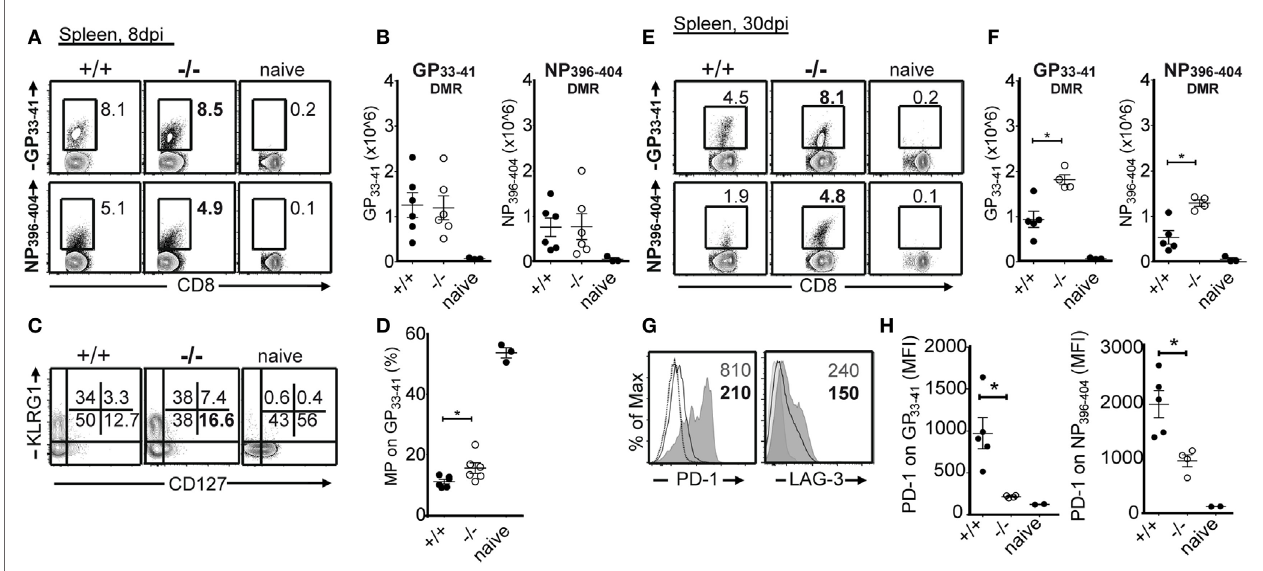
FigUre 2 | PTPN22 − / − mice exhibit enhanced virus-specific CD8 T cell numbers and reduced exhaustion phenotype. PTPN22 + / + (black circles) and PTPN22 − / − (white circles) mice were infected as described in Figure 1 . (a,B) Virus-specific splenic T cell populations were analyzed 8 dpi using GP 33–41 and NP 396–404 dextramers (DMRs) (gate: CD3 + B220 − CD8 + CD44 + ). (c,D) CD127 and KLRG1 costaining was used to distinguish terminal effector (CD127 − KLRG1 + ) and memory precursor (CD127 + KLRG1 − ) GP 33–41 + cells. (e,F) Virus-specific splenic T cell populations were analyzed 30 dpi using GP 33–41 and NP 396–404 DMRs (gate: CD3 + B220 − CD8 + ). (g,h) PD-1 and LAG-3 expression levels (geometric mean) were analyzed on GP 33–41 + cells from representative PTPN22 + / + (gray filled histogram) and PTPN22 − / − (black solid line) mice 30 dpi. Naïve CD8 T cells (black dotted line) were used as control. Representative contour plots or histogram overlays show one mouse